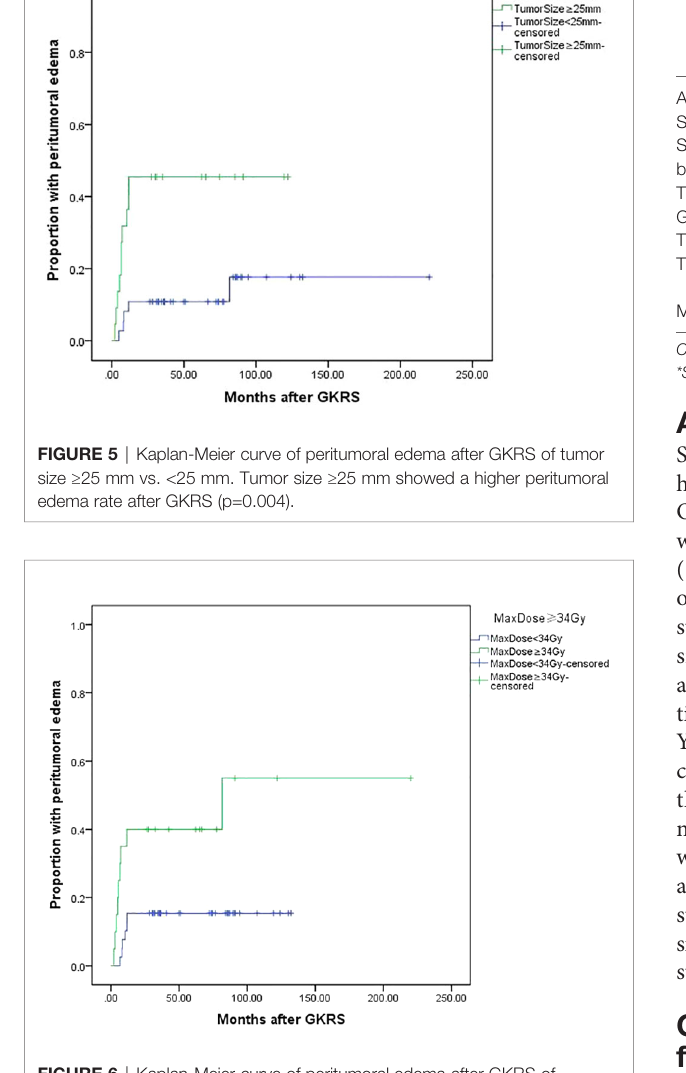
FIGURE 6 | Kaplan-Meier curve of peritumoral edema after GKRS of maximum dose ≥ 34 Gy vs. <34 Gy. Maximum dose ≥ 34 Gy showed a higher peritumoral edema rate after GKRS (p=0.005).